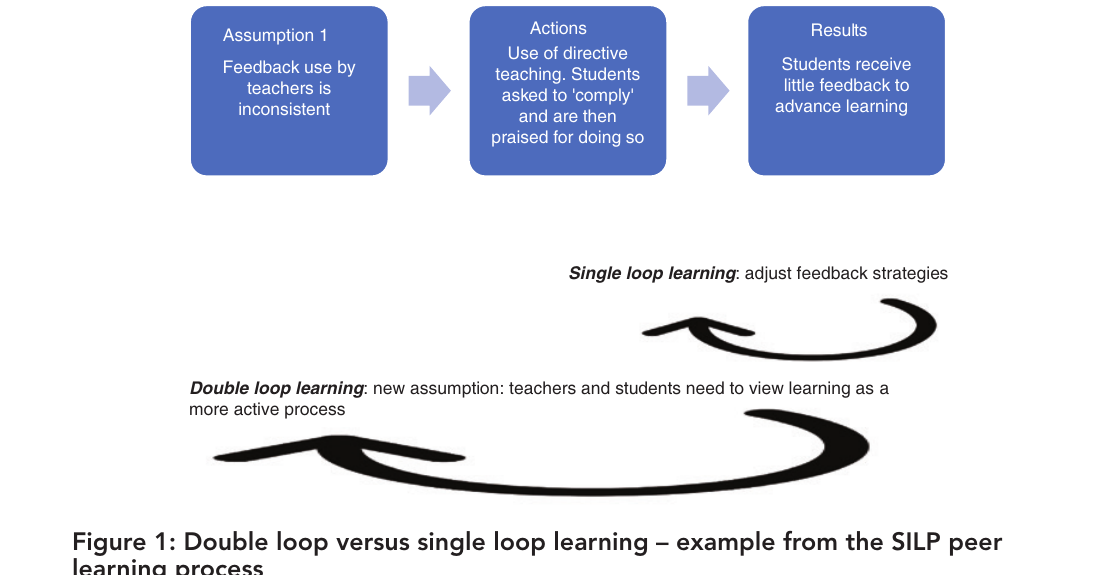
Figure 1: Double loop versus single loop learning – example from the SILP peer learning